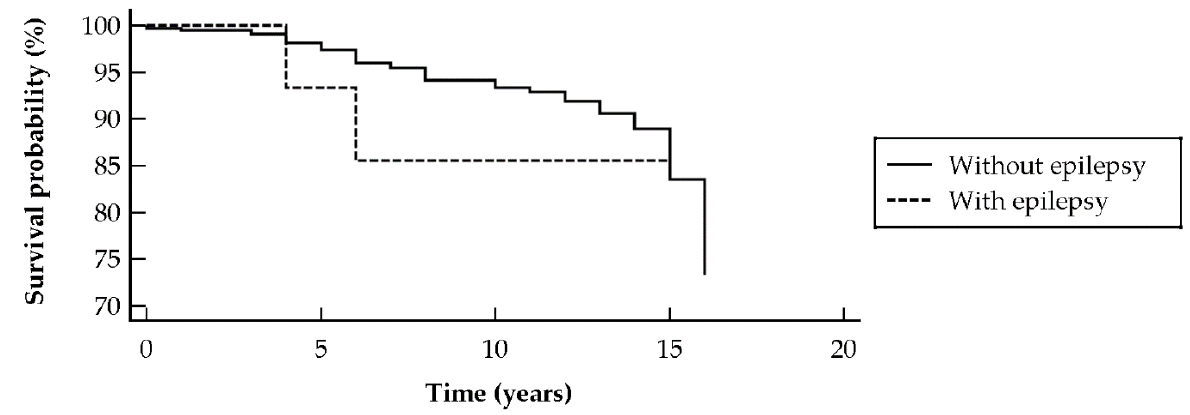
Figure 2. Kaplan–Meier curve survival of polymyositis patients with and without epilepsy, showing no significant impact on mortality rate.